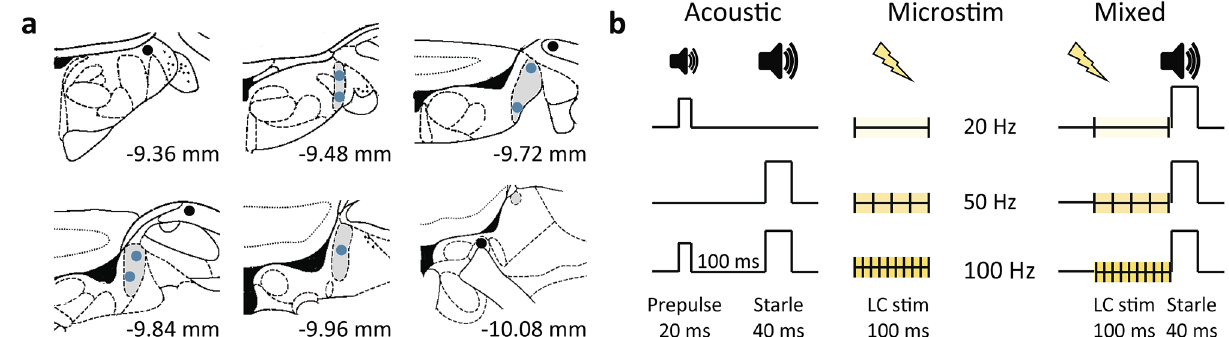
Figure 1. Experimental design. ( a ) Placement reconstruction of the stimulation electrode. The LC core is shown in grey; filled circles show the electrode tips. Different anterior–posterior planes are shown; numbers indicate the distance from bregma according to the rat brain atlas 84 . ( b ) Schematic representation of the experimental design. Each session included acoustic, microstimulation, and mixed (microstimulation preceded by startle) trials resulting in 9 trial types. The acoustic trials included prepulse, startle alone or preceded